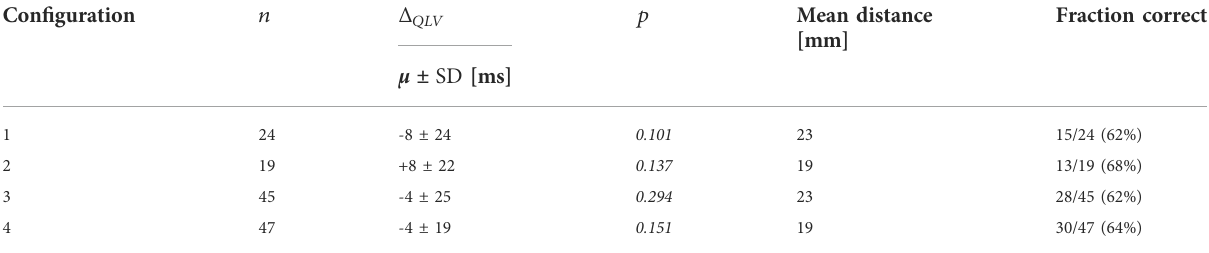
TABLE 3 Overall distribution of EGM con fi gurations and associated Δ QLV . Con fi guration n Δ QLV